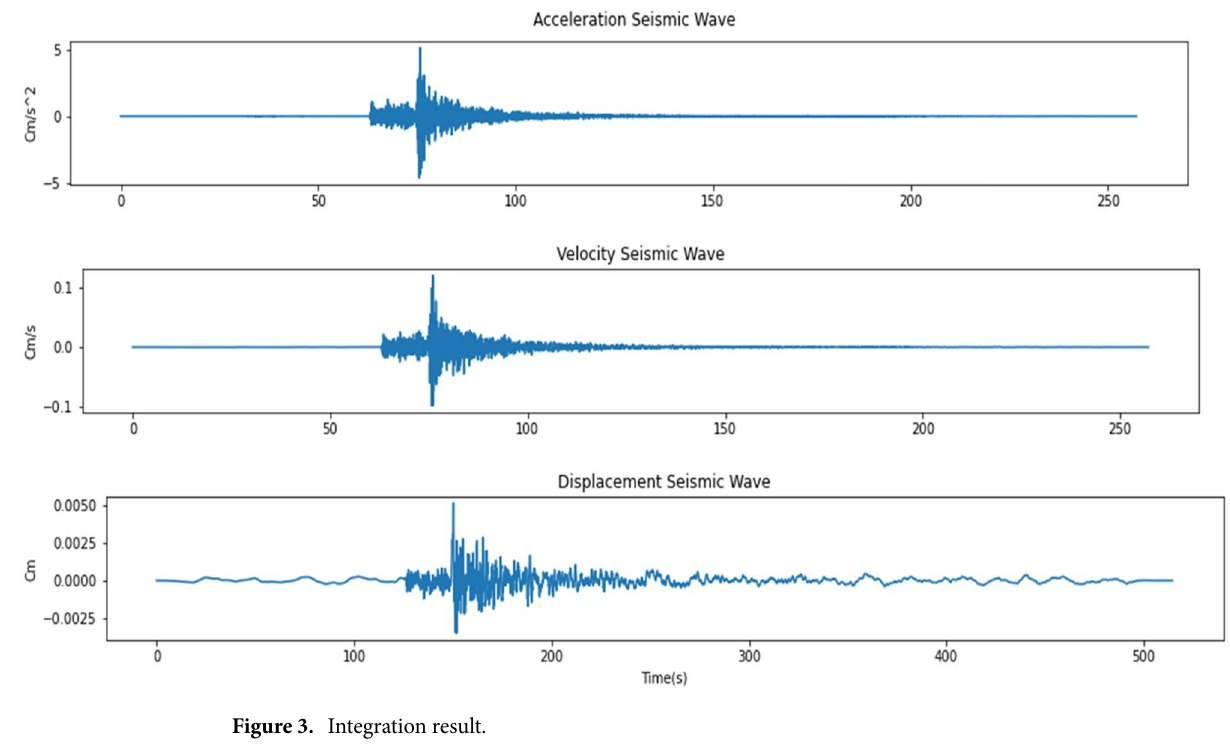
Figure 3. Integration result.